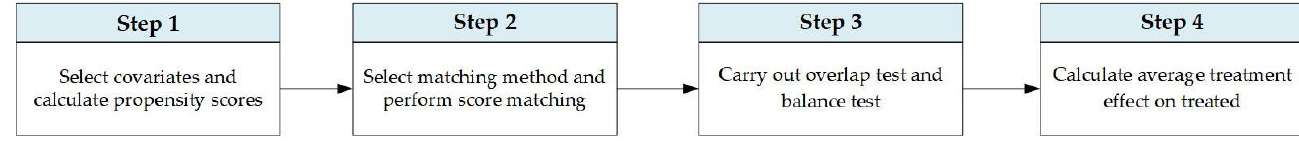
Figure 3. Research steps of PSM.